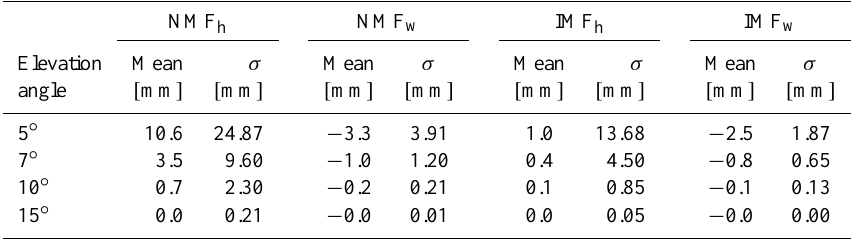
Table 3. Mean and standard deviation ( σ ) of the slant delay errors ∗ . NMF h NMF